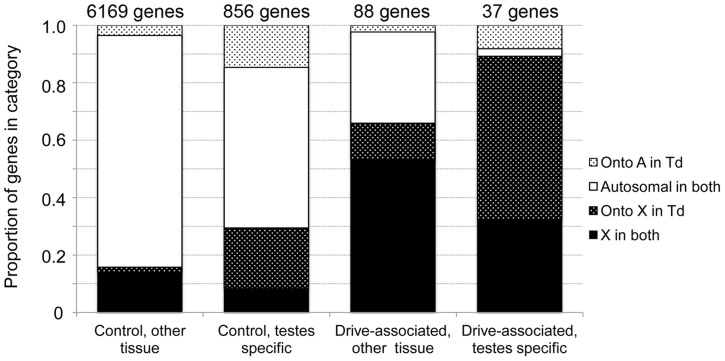
Drive-associated transcripts show an excess of X-linkage.Linkage of drive-associated and control genes determined from a comparative genomic hybridization experiment and evidence of gene movement inferred from the chromosomal locations of D. melanogaster orthologs. Based on previous analysis, X-linked genes in T. dalmanni are expected to be on 2L in D. melanogaster, so genes breaking this rule have moved in one lineage or the other. Solid bars indicate genes that have not moved: either they are 2L in D. melanogaster and X-linked in T. dalmanni (solid black) or not on 2L in D. melanogaster and autosomal in T. dalmanni (solid white). Stippled bars indicate genes that have moved, either onto the X in T. dalmanni/off of 2L in D. melanogaster (dark stippled) or onto an autosome in T. dalmanni/off of a non-2L chromosome in D. melanogaster (light stippled). Drive-associated transcripts are overwhelmingly X-linked especially if they are testes-specific (compare dark bars to light bars).